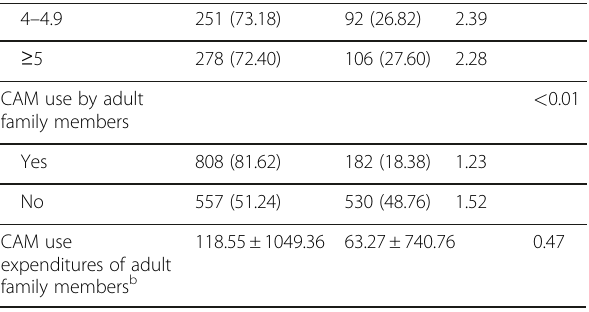
Table 1 Characteristics of the study participants according to the use of complementary and alternative